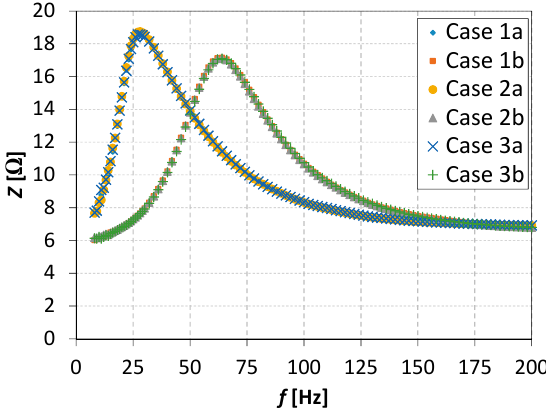
Figure 3. The impedance of synthetic jet actuator (SJA) as a function of frequency at a constant apparent power of P = 4 W.